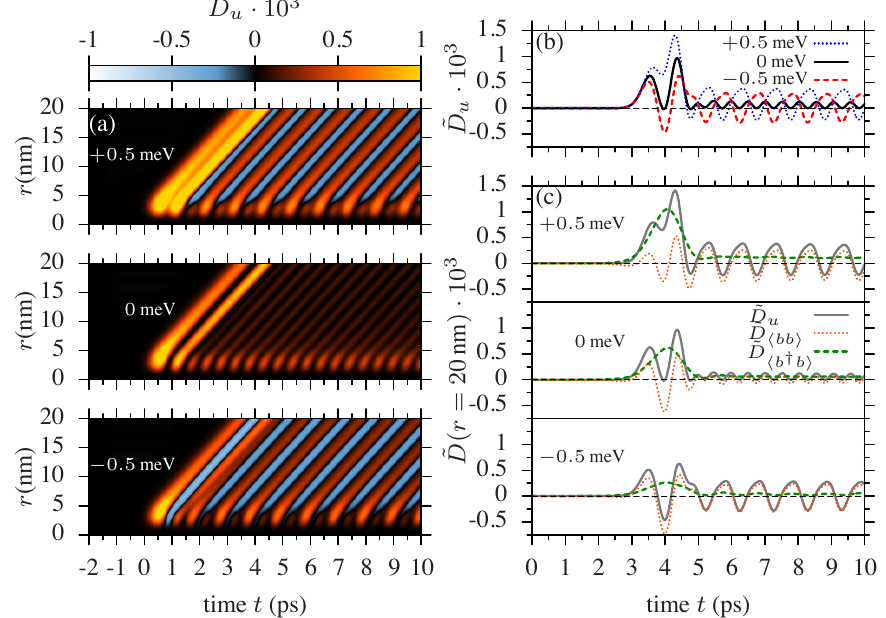
( r, t ) as a function of t and r u 1 = 6 ps − R